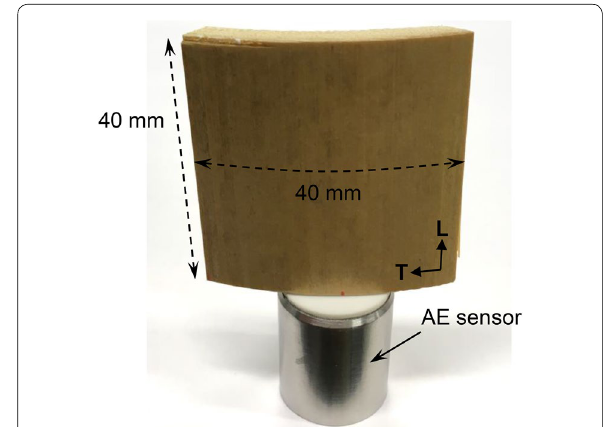
Fig. 1 Bamboo piece, used as an oviposition medium, with an AE sensor attached to the end